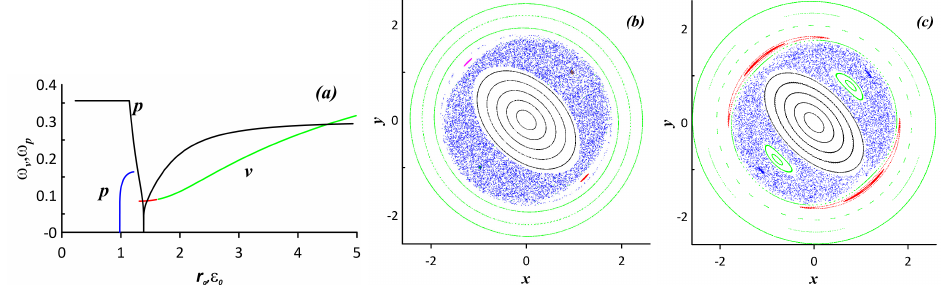
Figure 30. ( a ) The same as in Figure 29: ( b ) e = 0.01, γ = − 0.3, and the vortex oscillating (cid:101) = 1.50591; and ( c ) e = 0.01, γ = − 0.3, and the vortex rotating (cid:101) =